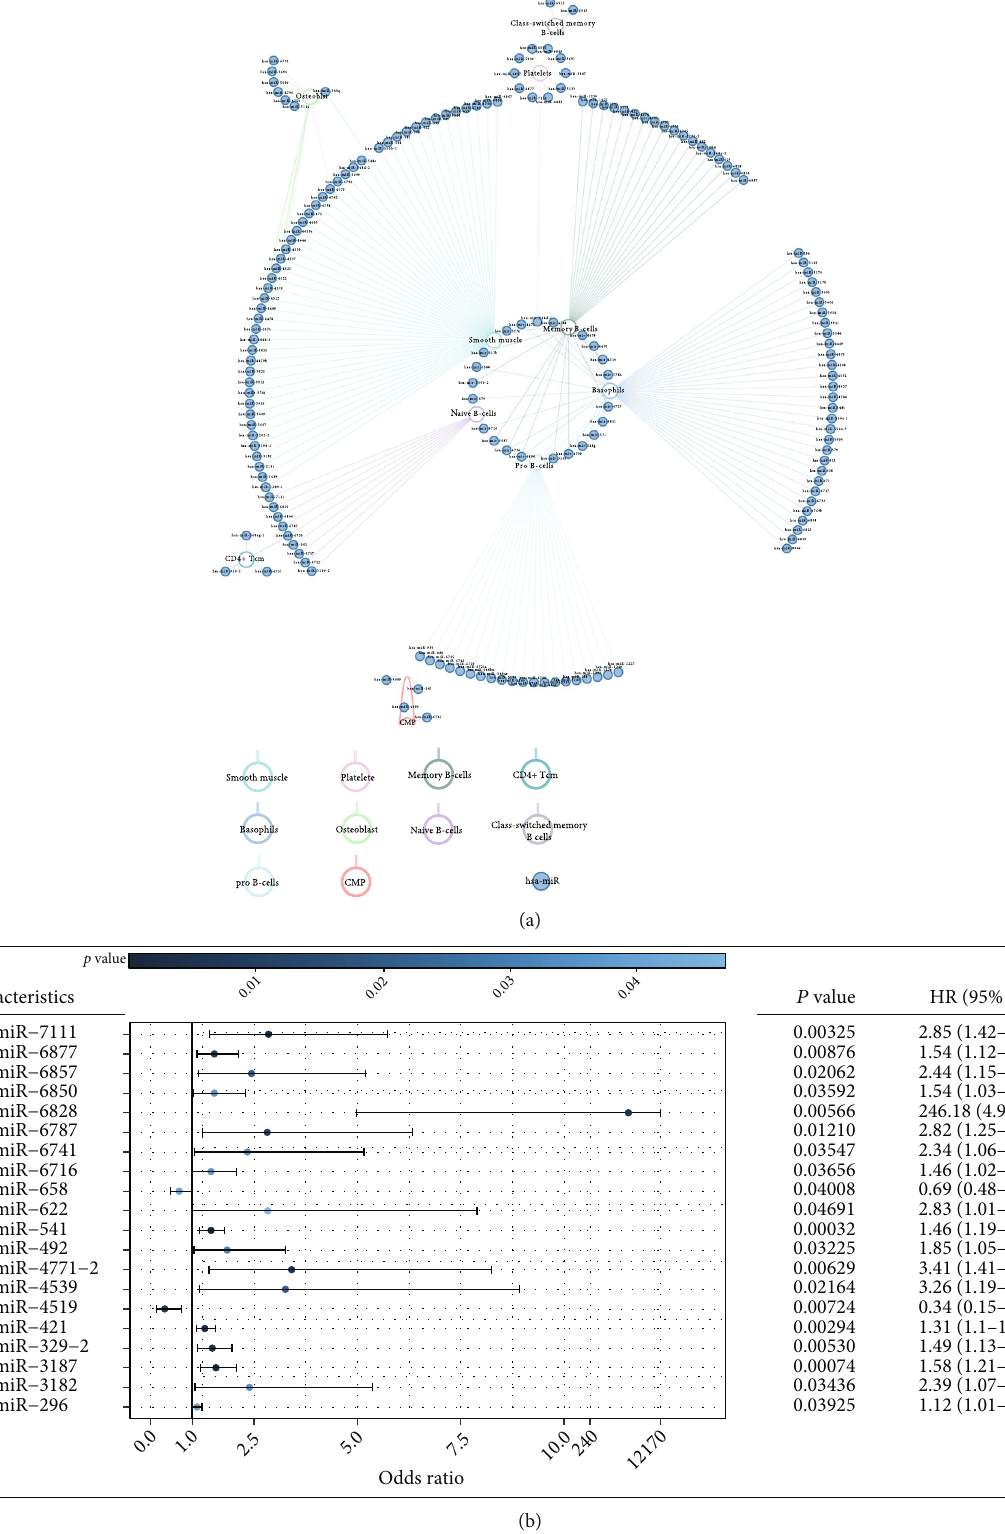
Figure 6: MicroRNAs related to cell components in the prognostic model. (a) Network map showed miRNAs that are related to 10 cell components in the prognostic model. (b) Forest plot of 20 miRNAs related to overall survival time and status. HR: hazard ratio; CI: con fi dence interval. A univariate Cox hazard ratio analysis demonstrated that among them, 18 miRNAs were risky ( HR > 1 : 0 ) and 2 miRNAs were protective ( HR < 1 : 0